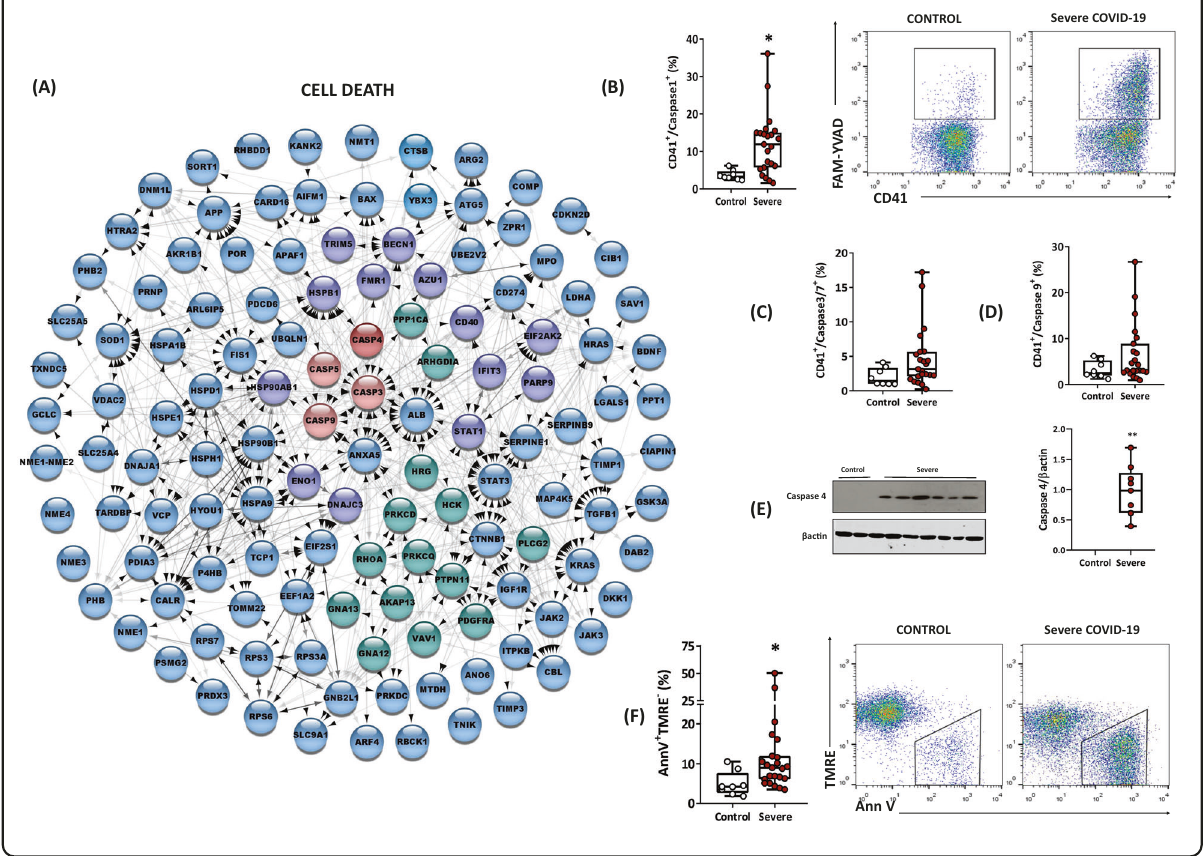
Fig. 3 Cell death regulation in the platelet proteome. A PPI related to programmed cell death and the apoptotic process. Colors represent biological processes. Proteins in blue are exclusive to programmed cell death and apoptotic processes. Proteins in green and purple are shared with PPI platelet activation and PPI response to type I interferon, respectively. In red, caspases 3 (DEP) and caspases 4, 5 and 9 (EPs) were upregulated in the COVID-19 group. B Caspase-1 activation in platelets isolated from healthy volunteers (controls) and patients with severe COVID-19. C Caspase 3/7 activation in platelets isolated from controls and patients with severe COVID-19. D Caspase 9 activation in platelets isolated from controls and patients with severe COVID-19 (percentage of positive cells by fl ow cytometry). E Western blot analysis of caspase 4 and β -actin expression in platelets isolated from three control subjects and 11 patients with severe COVID-19; and graph demonstrating band densitometry. F Cell death was evidenced by phosphatidylserine exposure (Annexin V positive) and collapse of the mitochondrial membrane potential (TMRE negative) in platelets isolated from control and patients with severe COVID-19 (percentage of cells by fl ow cytometry). Representative dot plots are shown in ( B ) and ( F ). Boxes indicate the median and interquartile ranges, and whiskers indicate minimal and maximal values in each group. * p < 0.05 compared to control with severe COVID-19 (unpaired t